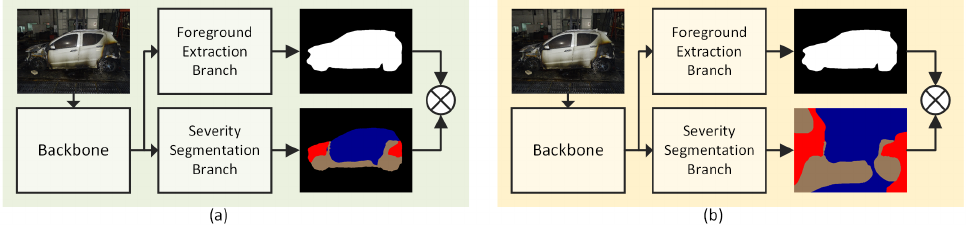
Figure 7. Two output methods (for the severity segmentation branch) in this paper: ( a ) 4-class output; ( b ) 3-class